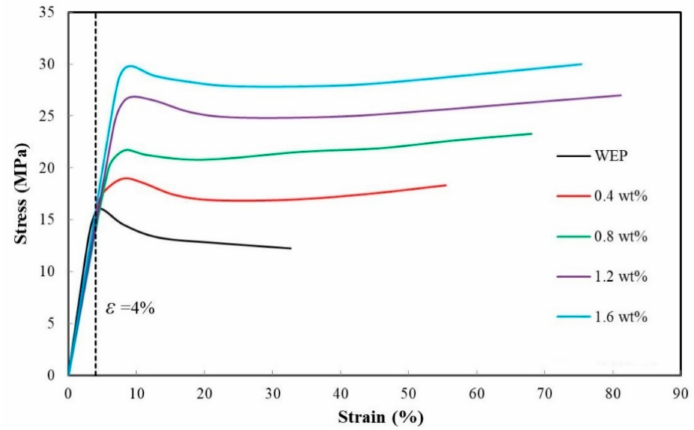
Figure 4. The stress–strain curves of the composite.